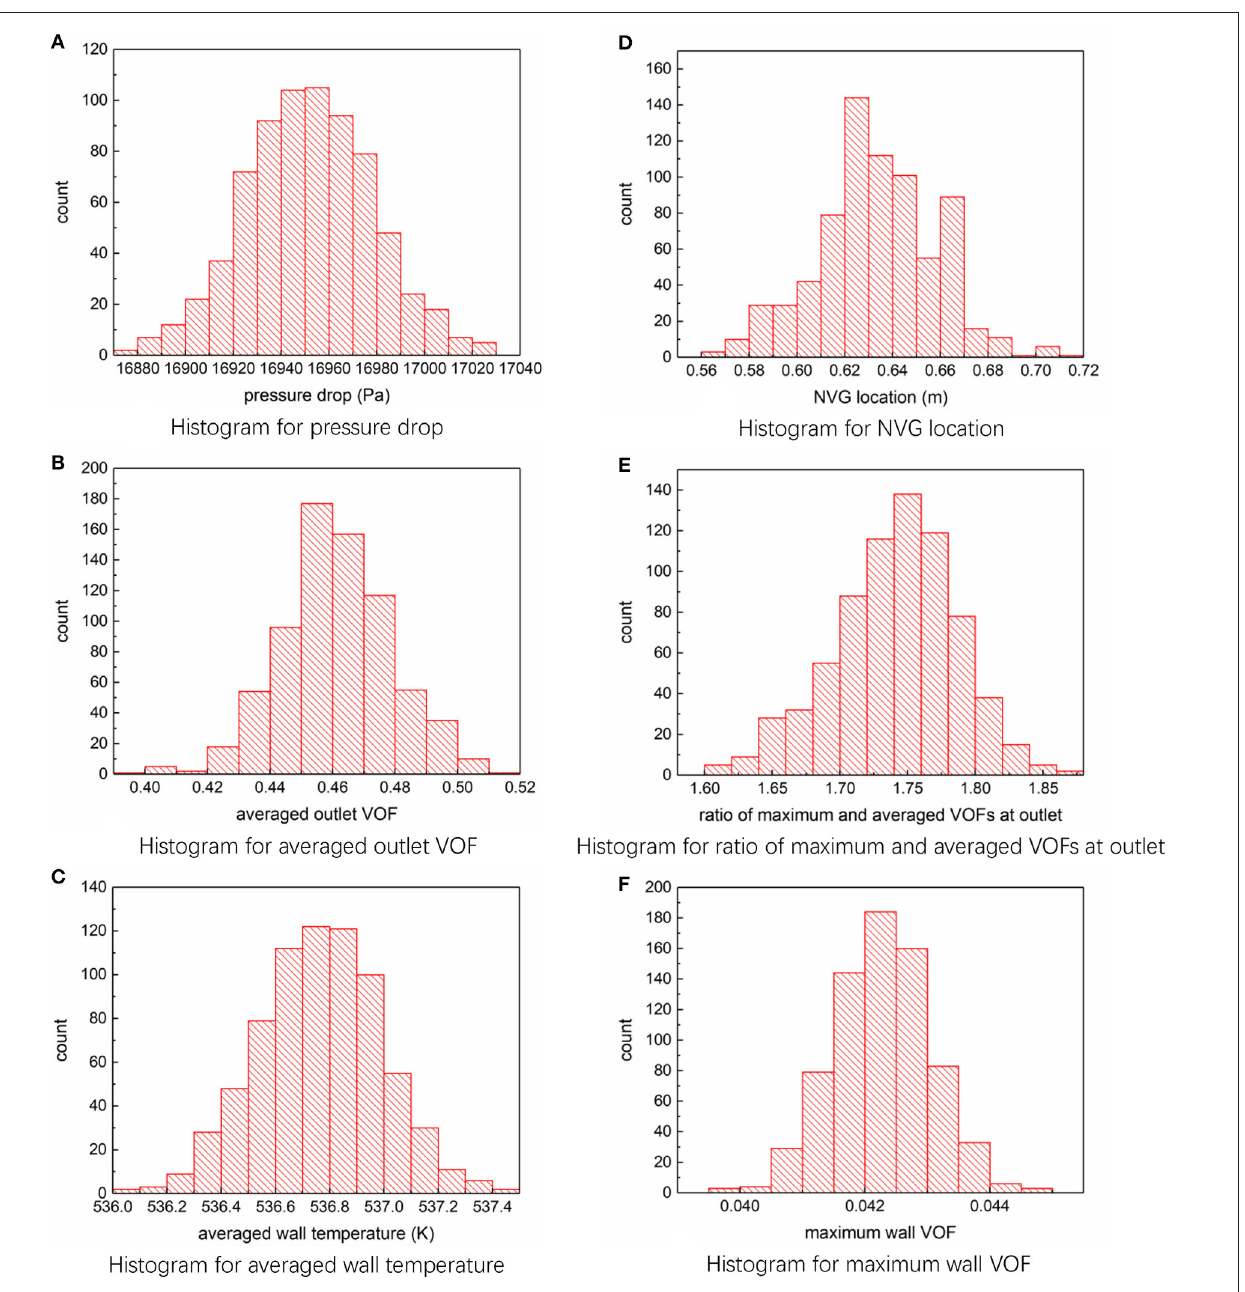
FIGURE 5 | Histograms for output parameters. (A) Histogram for pressure drop. (B) Histogram for averaged outlet VOF. (C) Histogram for averaged wall temperature. (D) Histogram for NVG location. (E) Histogram for ratio of maximum and averaged VOFs at outlet. (F) Histogram for maximum wall VOF.